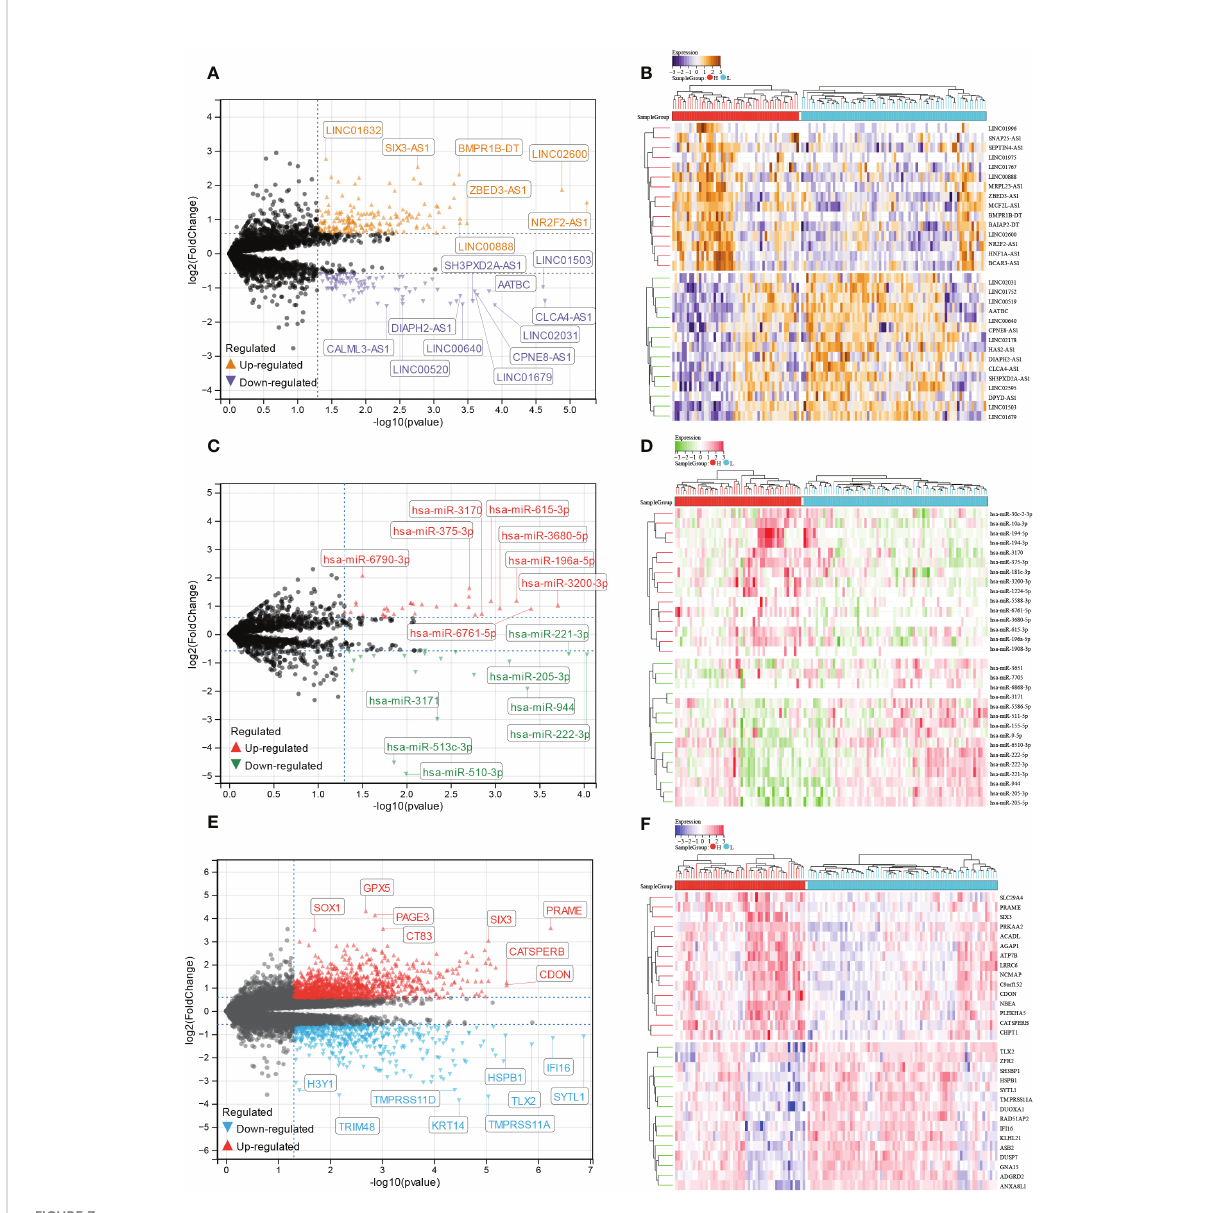
FIGURE 7 Identi fi cation of E6 splicing DEGs in CESC The volcano plot of (A) DEIncRNAs (C) DEmiRNAs (E) DEmRNAs in high and low E6ratio CESC patients. The differences are set as P value<0.05 and |log FC| >1.5. Heatmap showing 30 signi fi cantly (B) DEIncRNAs (D) DEmiRNAs (F) DEmRNAs of high and low E6ratio CESC